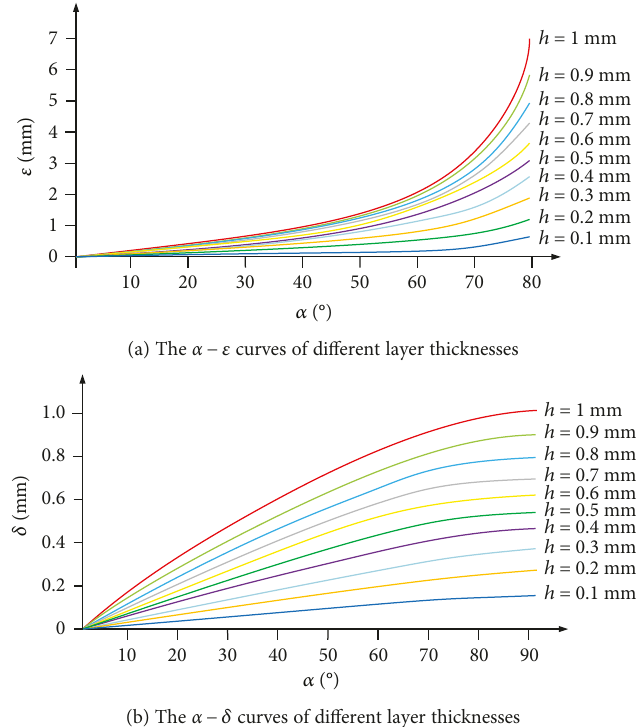
Figure 7: The relation curves of α − ε and α − δ on the surface of the forming parts are presented when R = 100mm